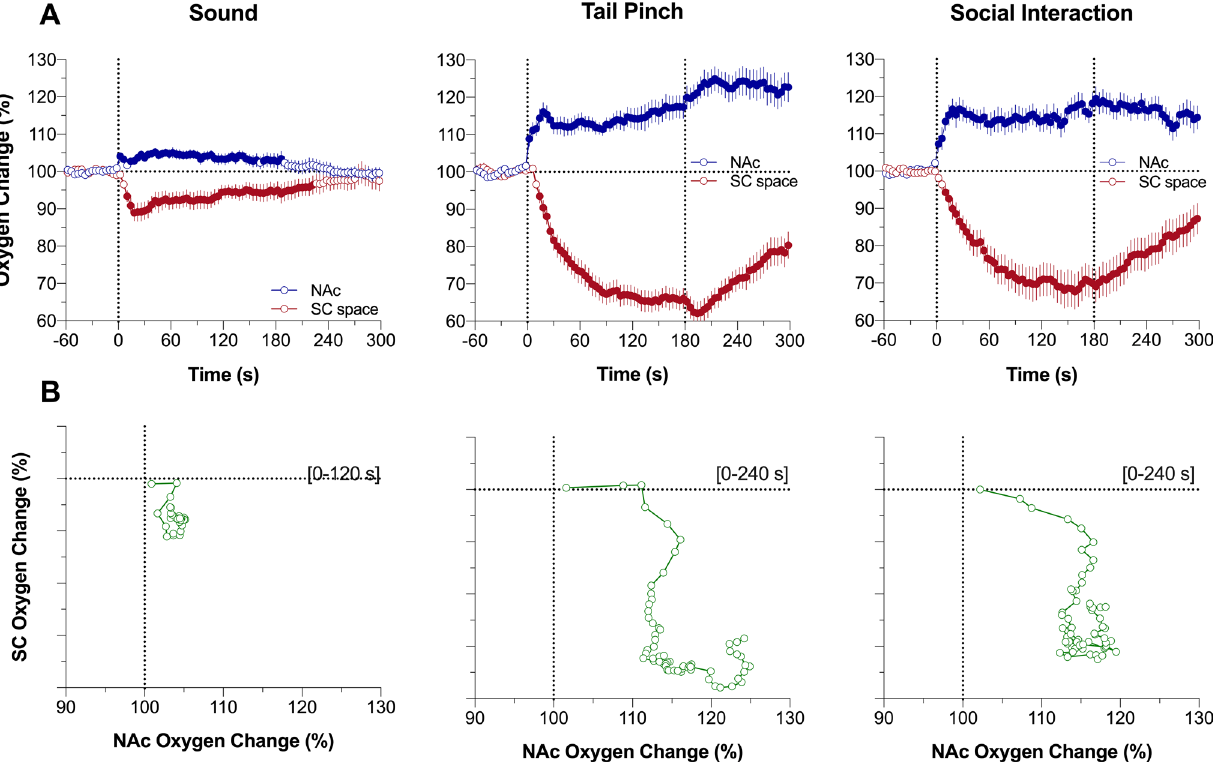
Figure 2. Rapid time-course analysis of relationships between changes in oxygen levels in the nucleus accumbens (NAc) and subcutaneous (SC) space induced by arousing stimuli in awake, freely moving rats. ( A ) Mean (± SEM) changes in oxygen levels relative to baseline (100%) calculated with 4-s time bins. Vertical hatched lines show onset and offset of stimulus presentation. Filled symbols mark values significantly different from pre-stimulus baseline ( P < 0.05). ( B ) Correlative relationships between oxygen changes in two recording locations shown for the time interval between the stimulus onset and maximal oxygen increase (duration of this interval is shown in brackets). Data were obtained in 6 rats; the numbers of averaged responses and F values of one-way repeated measure ANOVAs are shown in Supplementary